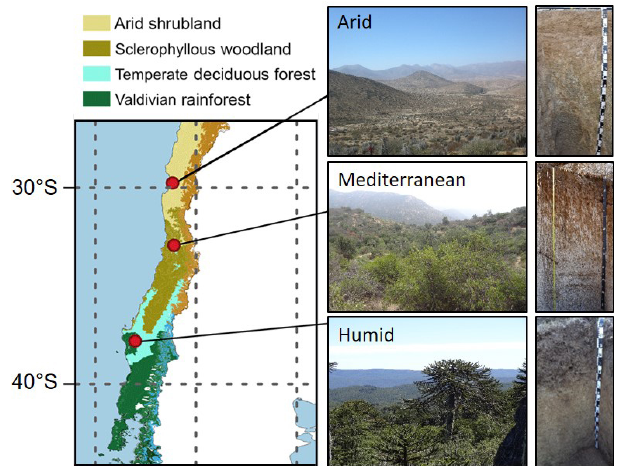
Figure 1. Location of the three study sites in the Coastal Cordillera of Chile together with a photo of the vegetation and soil at each of the sites. The map is taken from Werner et al. (2018) and was created based on Luebert and Pliscoff